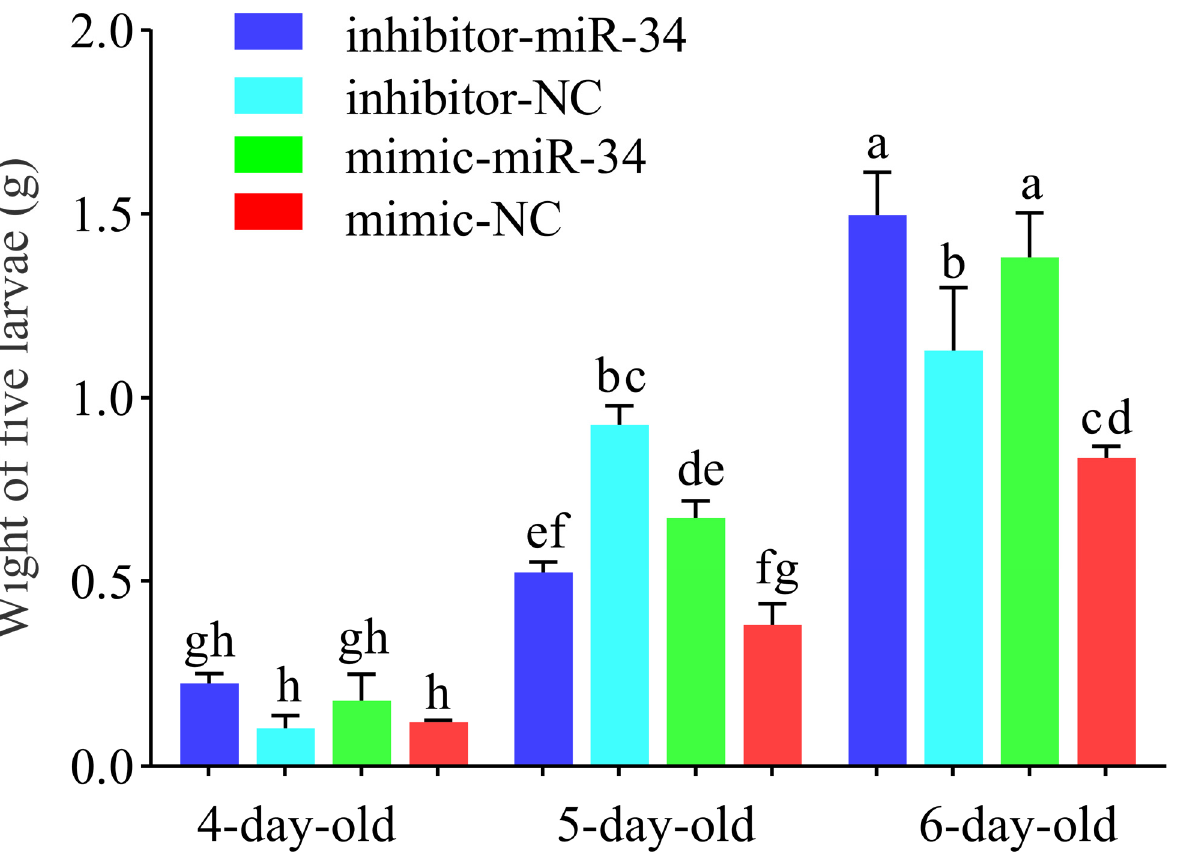
Figure 5. Statistics of body weights of A. mellifera larvae after ame-miR-34 overexpression and knockdown. SPSS statistics software was used to conduct one-way analysis of variance (ANOVA) for the average body weight of larvae in each group, with p < 0.05 as the significance threshold. Experimental data were compared and analyzed by the Tukey test and the letter significance labeling methods. Data are mean ± SE; the same lowercase letters above the curve indicate non-significant difference ( p > 0.05), while the different lowercase letters above the curve indicate significant difference ( p < 0.05) (Tukey test).